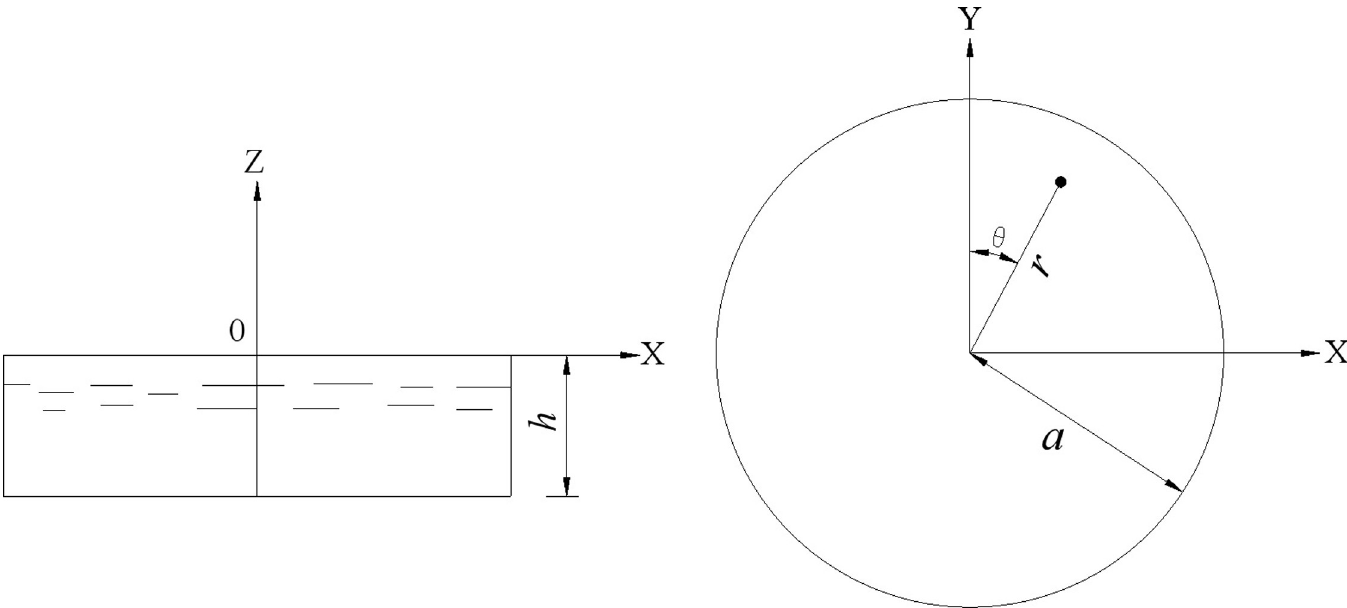
Fig 2. Schematic diagram of geometry and coordinate system of the circular